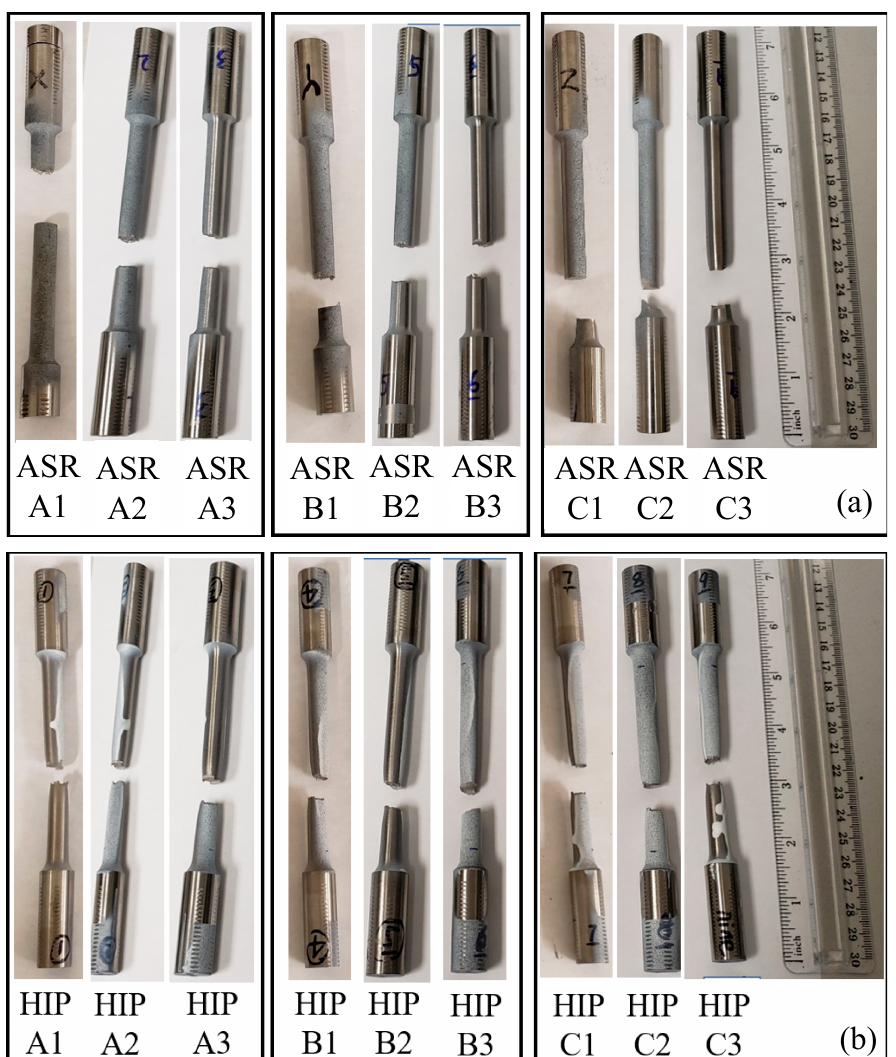
Figure 1. Fractured tensile specimens: ( a ) as-stress relieved (ASR) and ( b ) hot isostatically pressed (HIP) Ti-6Al-4V ELI alloy. Sample series A and B were horizontally built in X and Y direction, while C was built vertically in the Z direction, which is the build direction of the LPBF. Note that minor size variation is due to the photography and not the sample size.